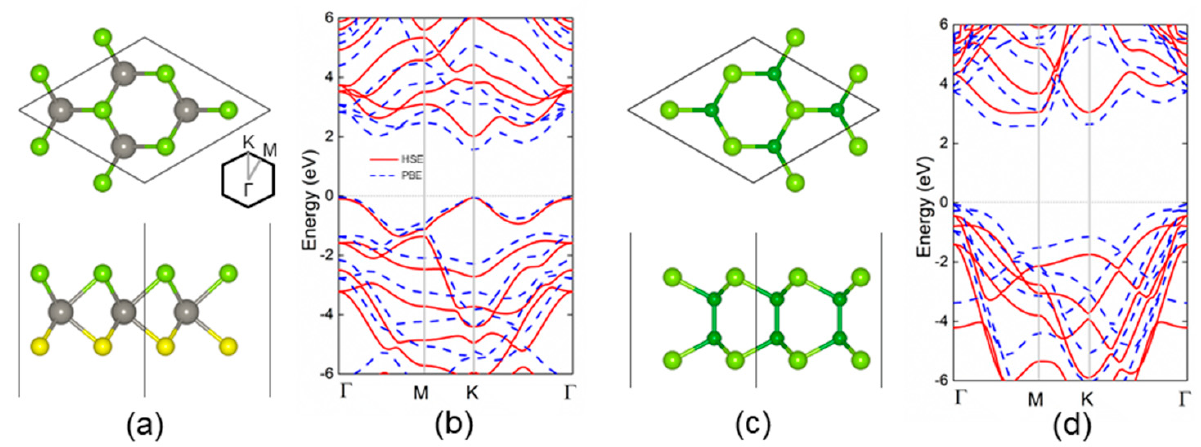
Figure 1. The crystal structure of the ( a ) WSSe and ( c ) BSe monolayers; the band structure of the ( b ) WSSe and ( d ) BSe monolayers calculated by HSE06 (red line) and PBE (blue marks) methods, respectively. The gray, grey, green and yellow marks represent Se, W, B and S atoms, respectively. The Fermi level is set by 0 pointed by the gray dashed line.